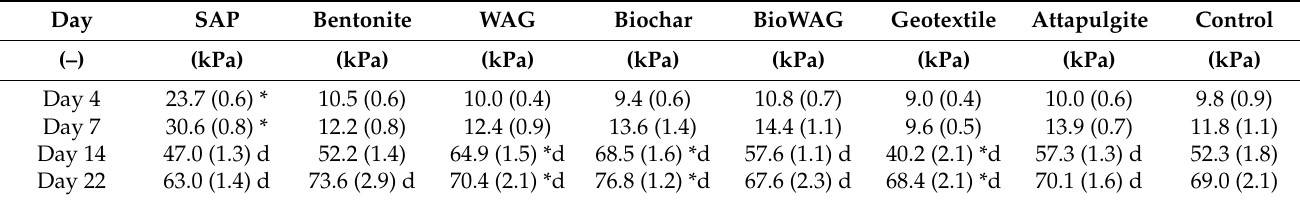
Table 4. Mean soil matric potential values in analysed drying